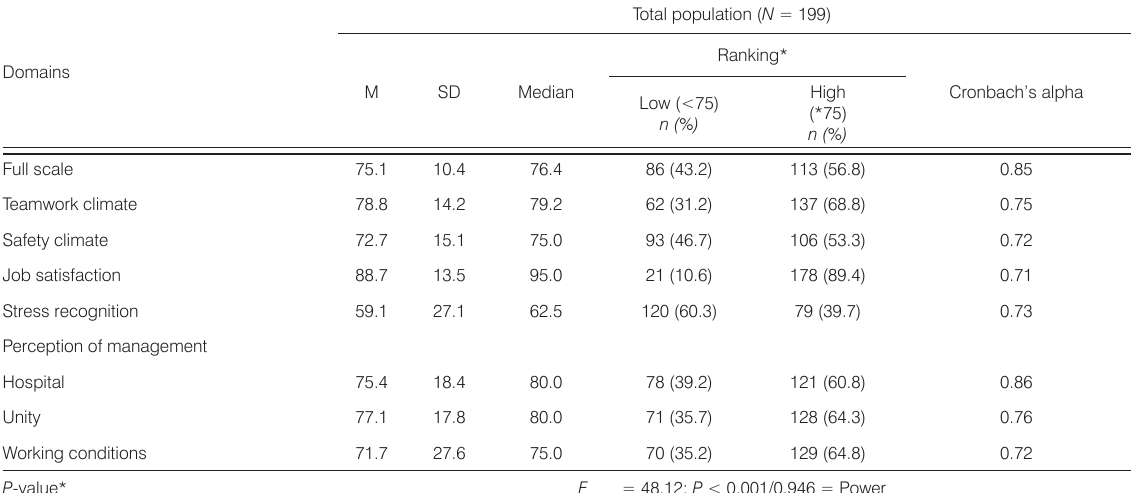
Table 2. Measures of central tendency and variability of workers’ SAQ